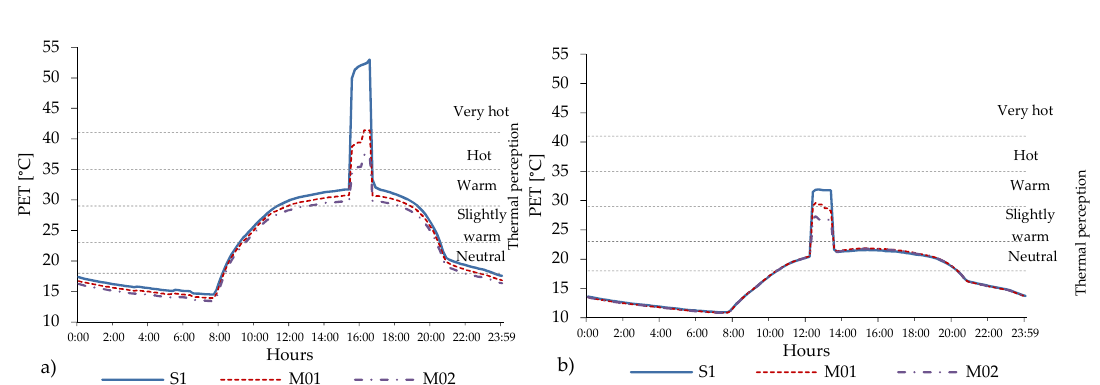
Figure 12. Daily evolution of the PET level in compact low-rise urban area for scenarios S1, M01 and M02 registered in R04, for the worst orientation NE-SW ( a ) and the best orientation NW-SE ( b ).